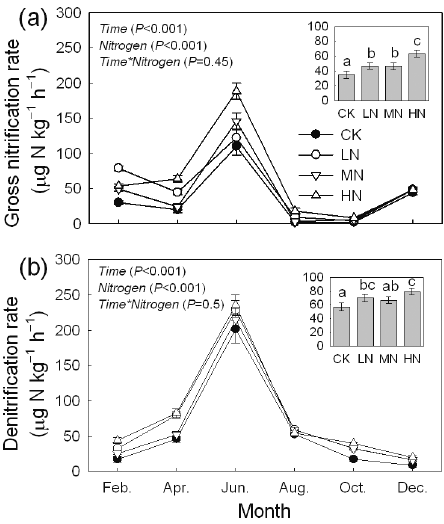
Figure 4. Seasonal variations of soil gross nitrification and denitrificantion rates in a Bambusapervariabilis 6 Dendrocala- mopsisdaii plantation in 2009 (mean ± SE, n =3). Average values of yearly measures were exhibited in the histograms (mean 6 SE, n =3). Results of repeated measures ANOVAs are shown in text. Different letters indicate significant difference among N addition treatments when nitrogen effect is significant ( P , 0.05, Fisher’s least significant difference test). CK, LN, MN and HN are as in Fig.